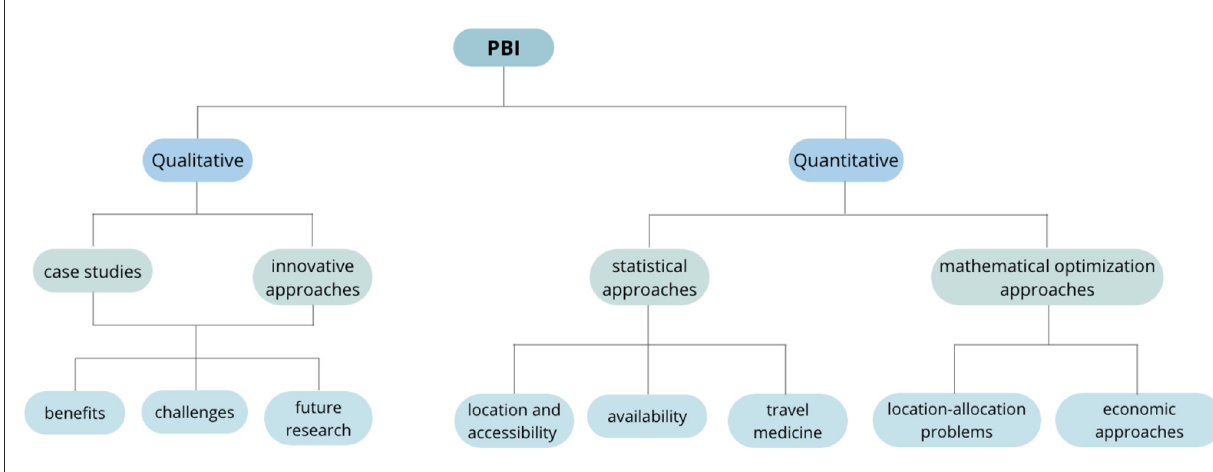
FIGURE2 Grouping scheme of papers related to pharmacy-based immunization.